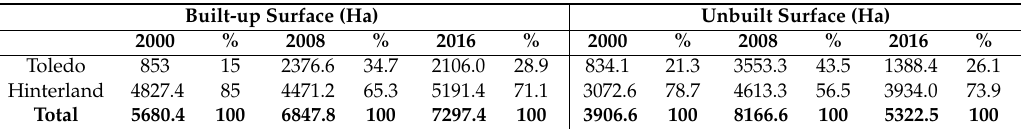
Table 2. Evolution of the built-up and unbuilt areas between 2000 and 2016 in Toledo and in its hinterland of 30 kms. Source: Land Registry [64].